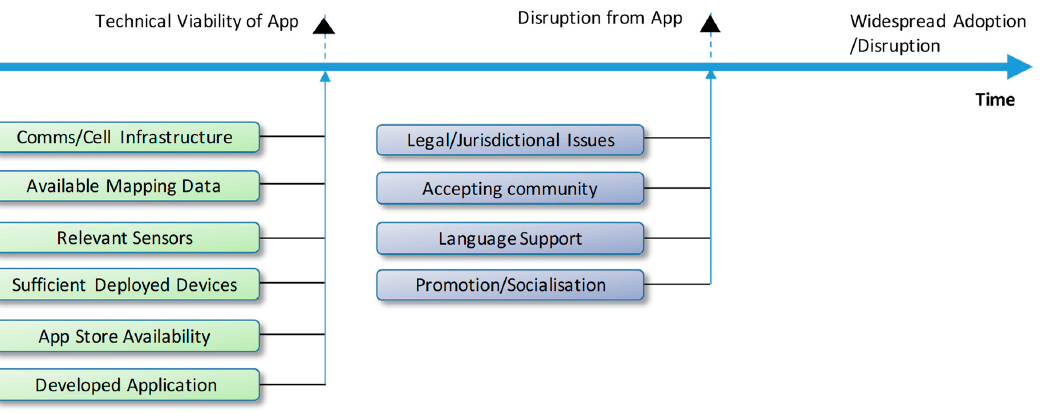
ff ecting Uber Figure 10. Issues affecting Uber disruption. Figure 10. Issues a